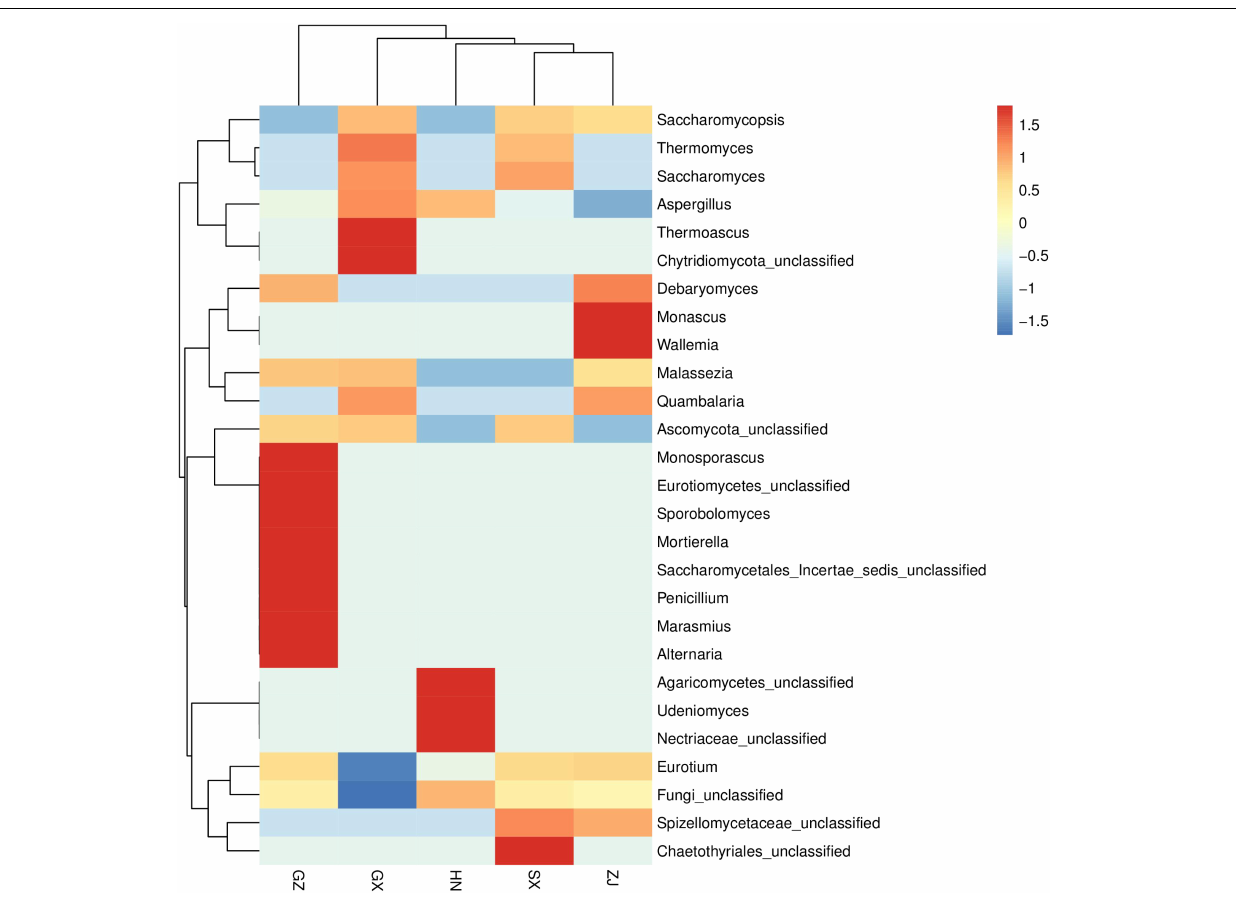
including Chlamydomonas , Penicillium , and Aspergillus